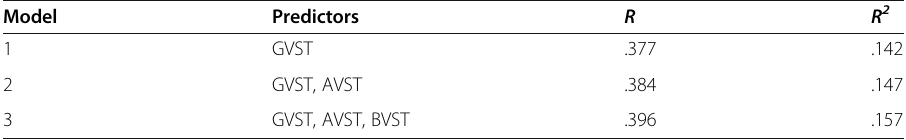
Table 4 Regression analysis of vocabulary predictors and GPA Model